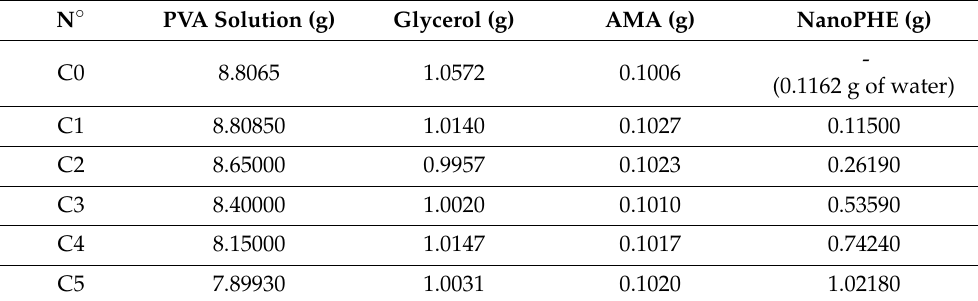
Table 1. Quantity of PVA solution, Glycerol, AMA, and NanoPHE for the preparation of film-forming solutions with a range of five concentrations of